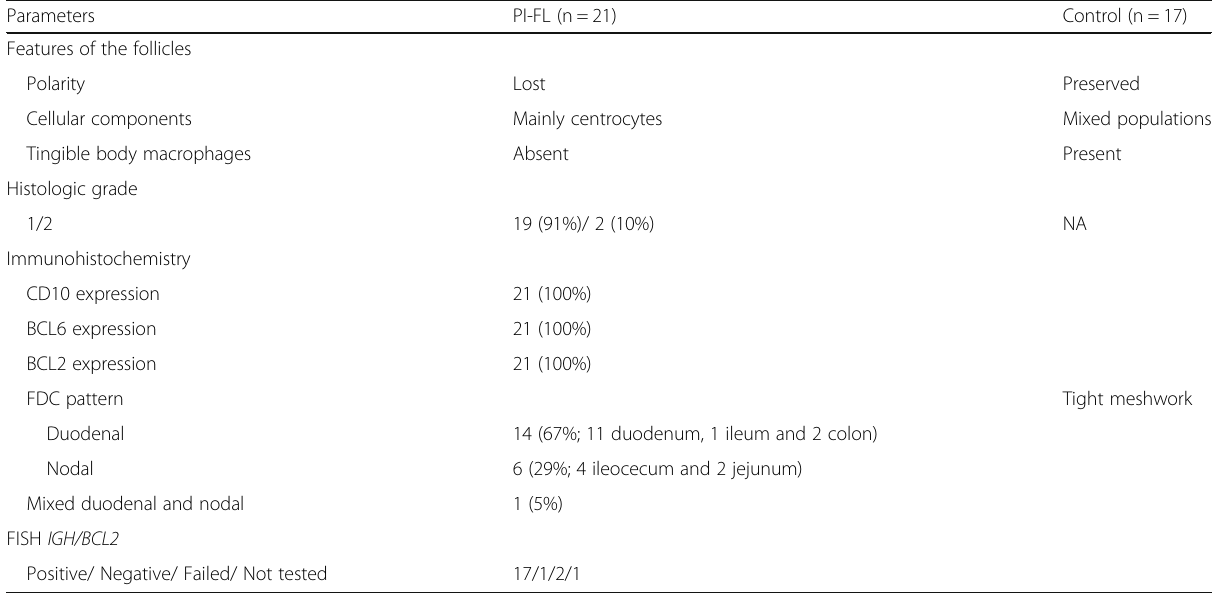
Table 2 Histopathologic, immunohistochemical and FISH findings of PI-FL and control cases with reactive lymphoid hyperplasia Parameters Features of the follicles